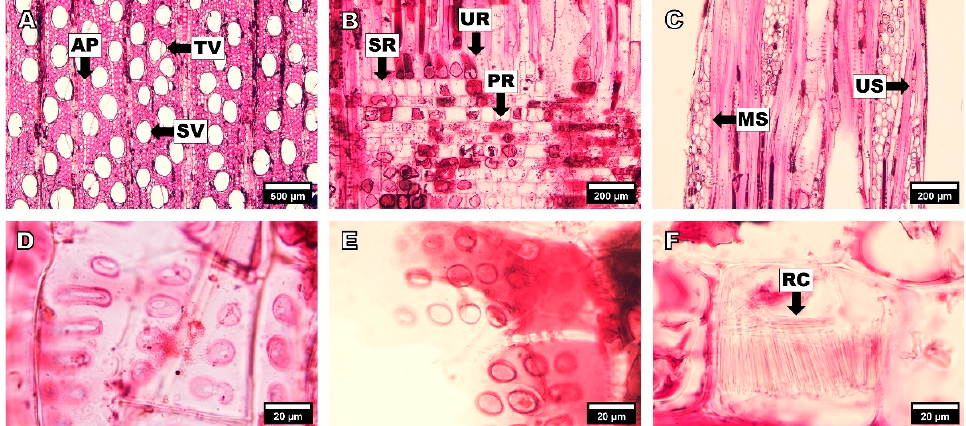
Figure 3. Optical micrographs of Dillenia pentagyna Cross-section ( A ), radial section ( B ), tangential section ( C ), intervessel pits ( D ), vessel-ray pits ( E ), and mineral inclusions ( F ). Solitary vessel (SV), tangential multiple vessel (TV), axial parenchyma (AP), procumbent body ray (PR), square body ray (SR), upright body ray (UR), uniseriate ray (US), multiseriate ray (MS), and raphides (RC). In the radial section, the rays were composed of procumbent body ray cells with over four rows of upright and/or square marginal cells (Figure 3B). The perforated plates were scalariform. Disjunctive ray parenchyma cell walls were also observed. Vessel-ray pits were much reduced in borders to apparently simple with rounded or angular shapes (Figure